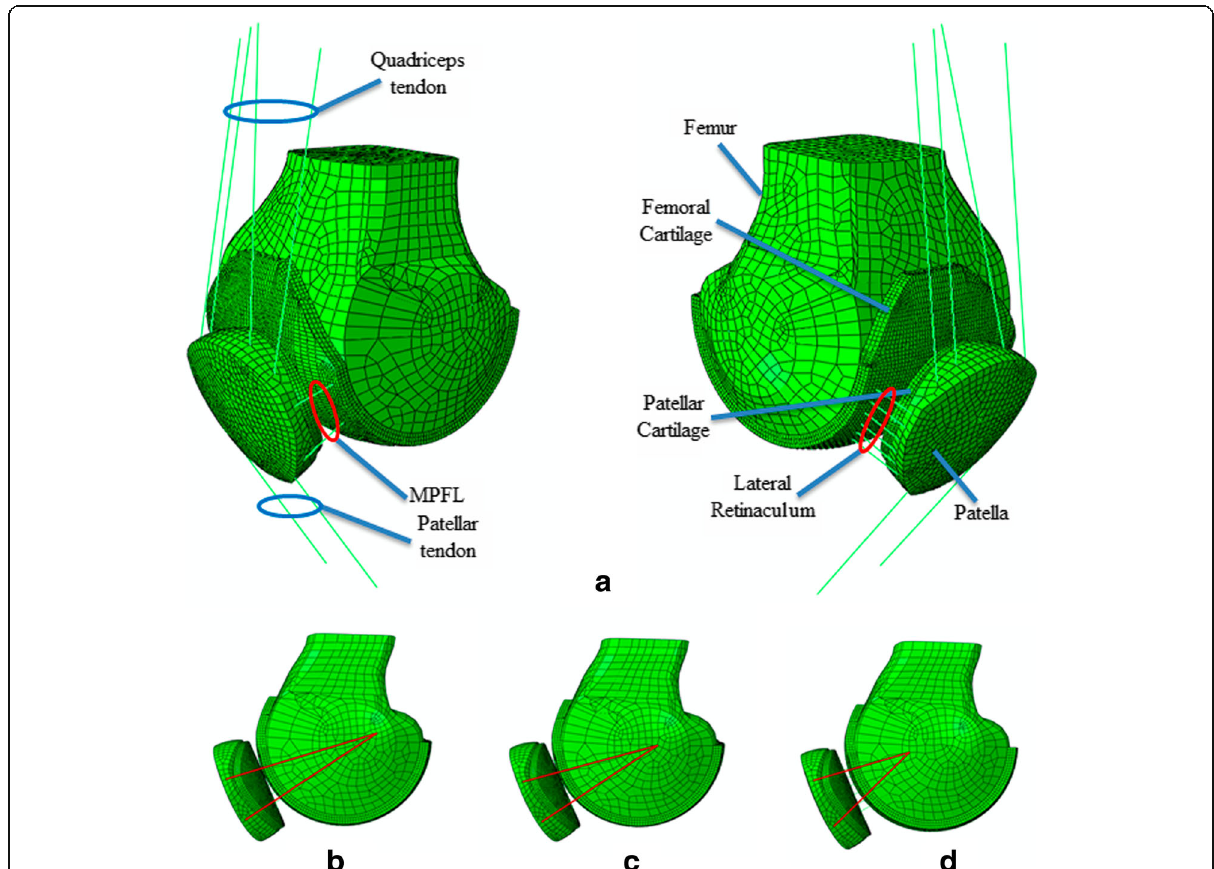
Fig. 2 a Final model reconstruction including the joint ligaments and tendons. b Reconstruction with a patellar bone fixation point and an anatomic femoral fixation point. c Reconstruction with a patellar bone fixation point and a non-anatomic femoral fixation point that has